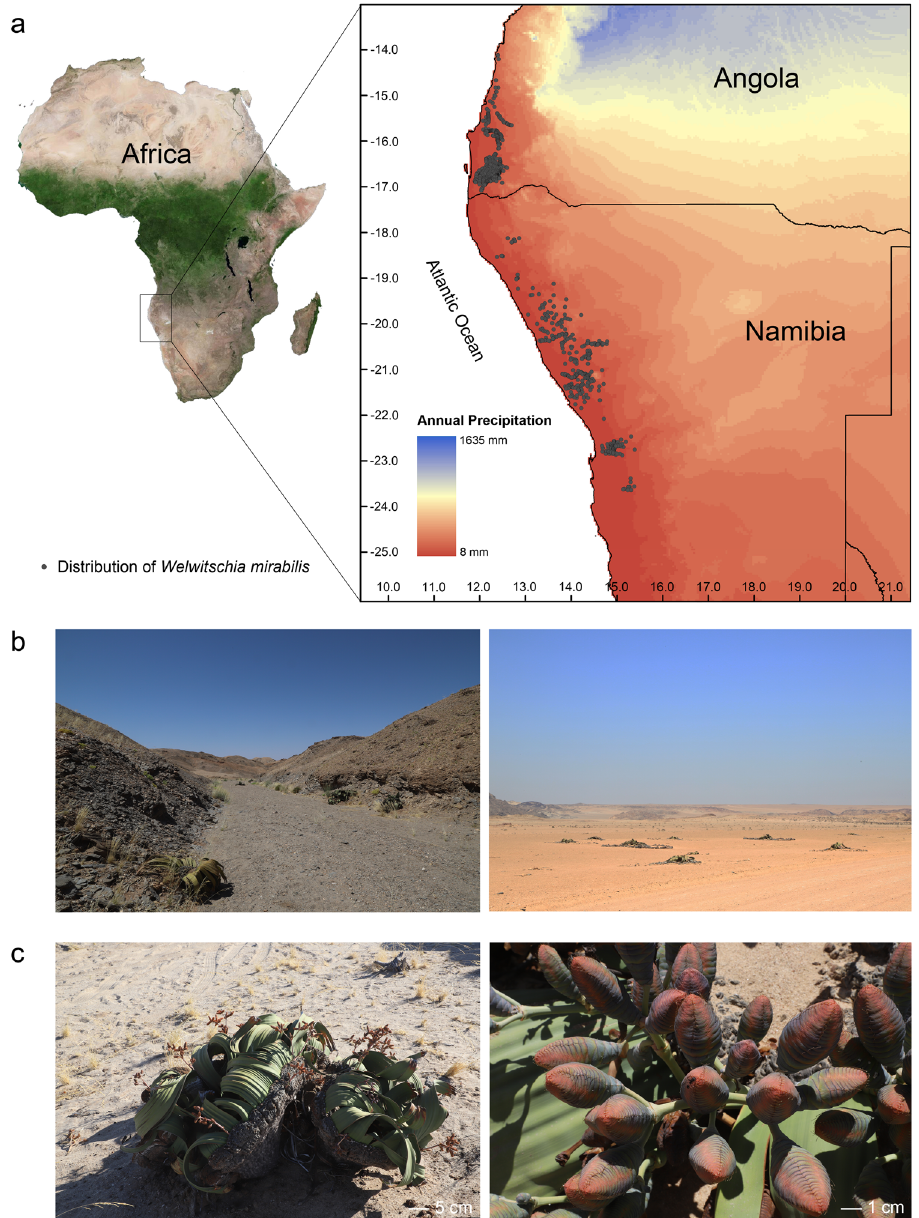
Fig. 1 Geographical location and typical habitat of Welwitschia mirabilis . a The annual precipitation of the area in Africa where the species grows measured using the Koeppen-Geiger index. The distribution of W. mirabilis (gray dot) is based on occurrence records available from the Global Biodiversity Information Facility (GBIF) and new data from Professor N. Jürgens (pers. comm.). b Two typical niches, an arid valley, and coastal desert. c Male (left) and female individuals (right) in